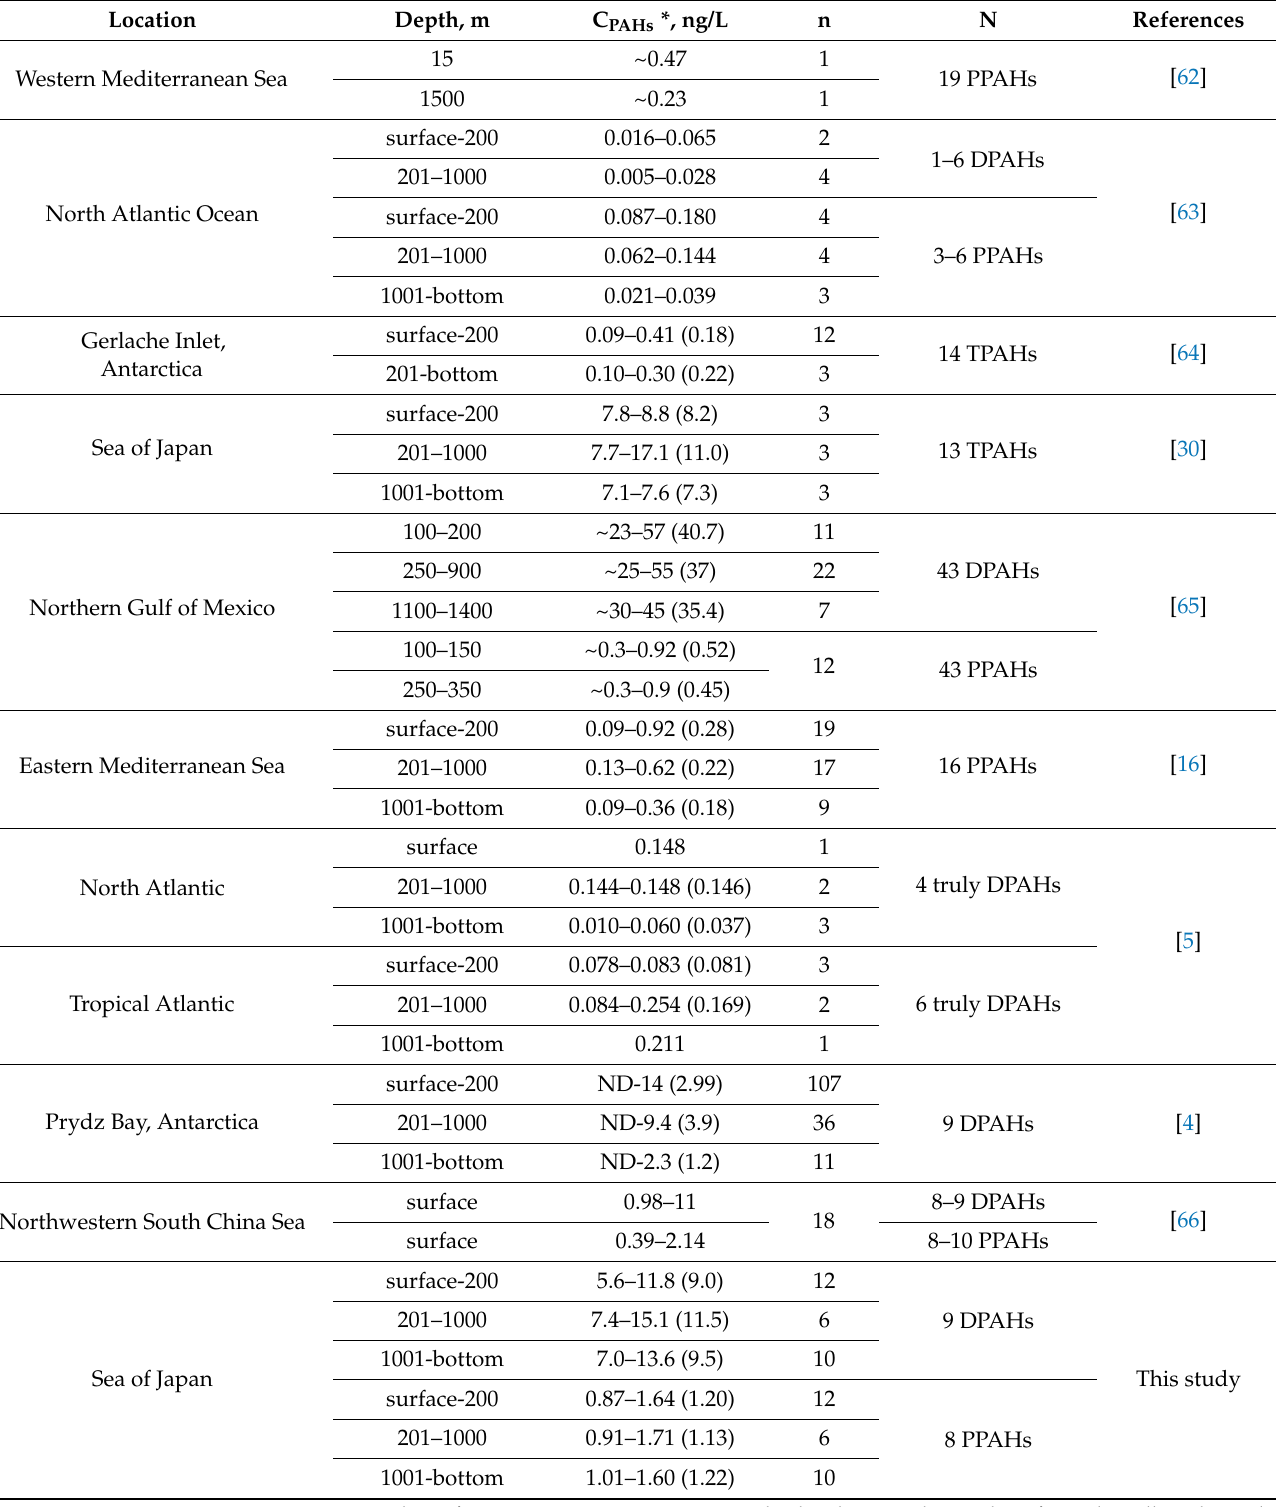
Table 2. PAH concentrations in the epipelagic, mesopelagic and bathypelagic realms in the present study and other locations